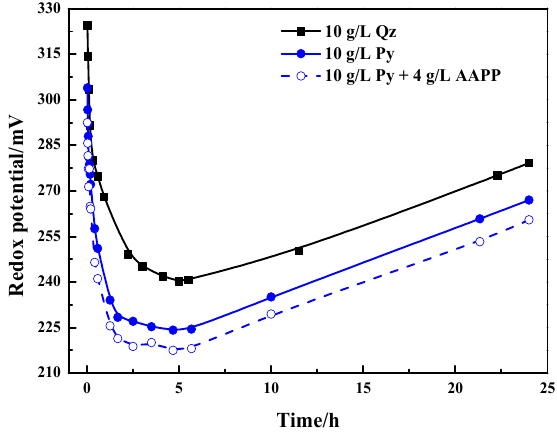
Figure 4. Variation of the mixed slurry potential with time during thiosulfate leaching of gold in the presence of 10 g/L pyrite and 10 g/L quartz without and with the addition of 4 g/L AAPP.